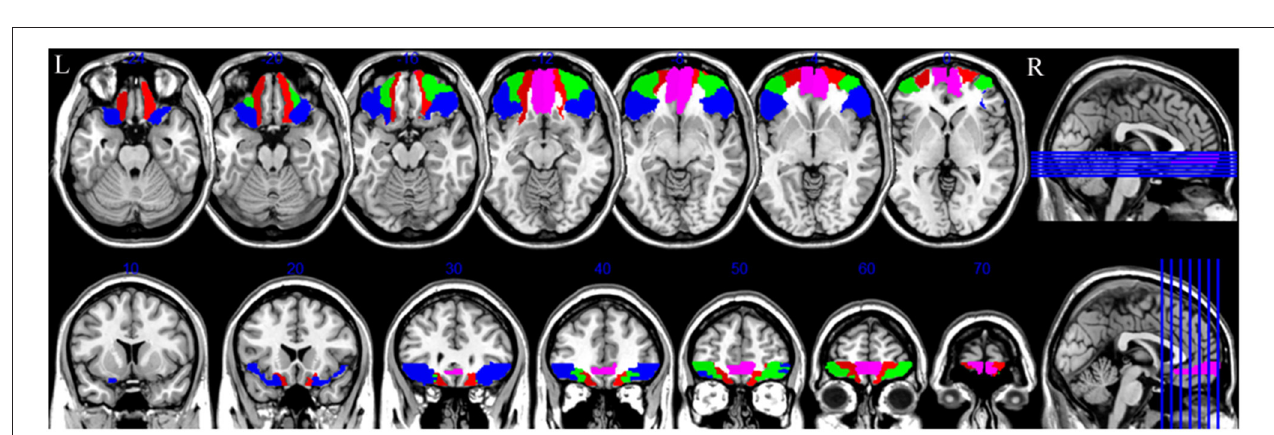
FIGURE 3 | Bilateral orbitofrontal cortex. The red part is superior frontal gyrus, orbital part; the pink part is superior frontal gyrus, medial orbital; the green part is middle frontal gyrus, orbital part; the blue part is inferior frontal gyrus, orbital part. R, right.